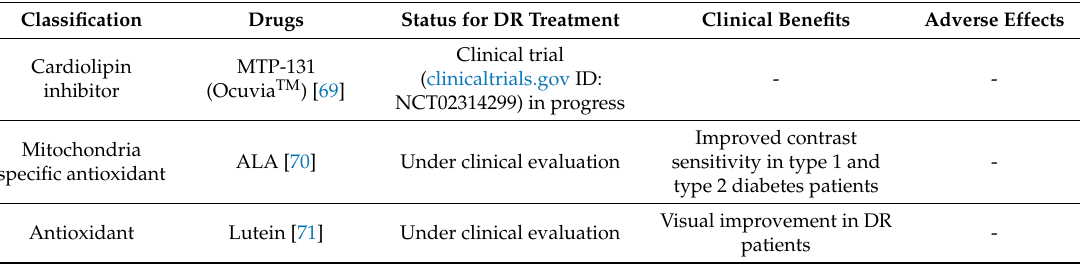
Table 4. Other treatments for the treatment of